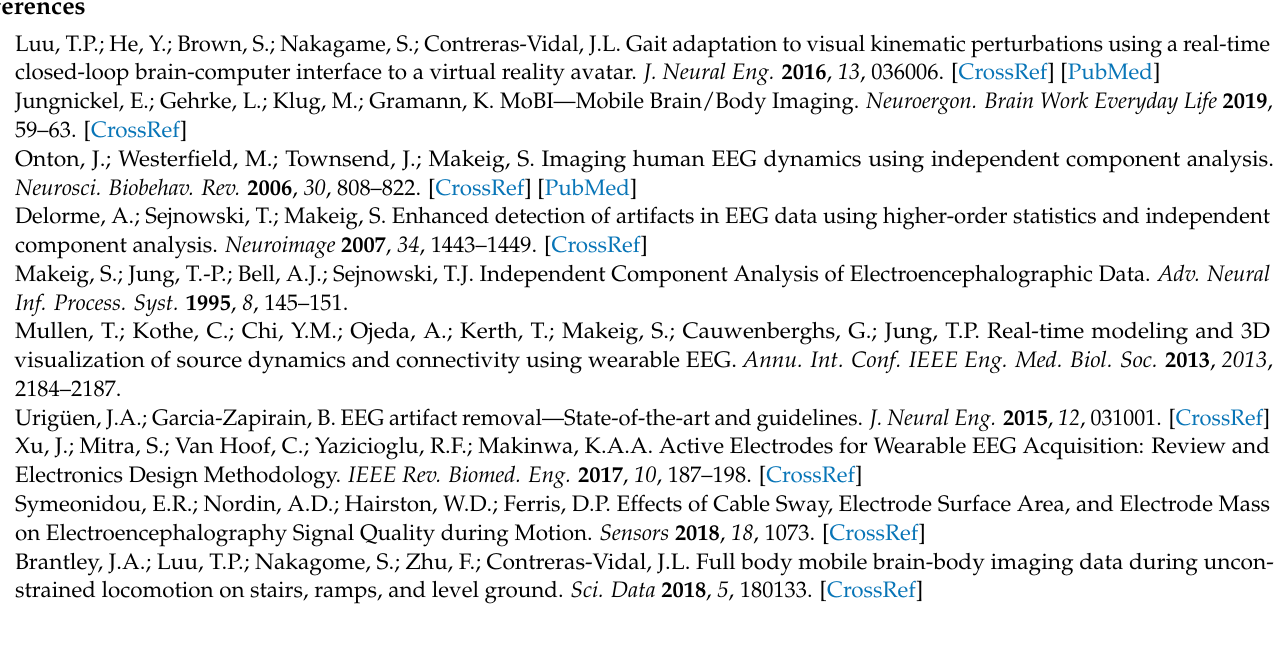
Figure S3: Group average time series correlations; Figure S4: Resultant head and body IMU spectral properties of the last 3 participants who had the head IMU; Figure S5: Quantitative assessment of the different iCanClean pipelines that use a different number of noise electrodes; Figure S6: Components from a single participant after the Minimal pipeline; Figure S7: Components from a single